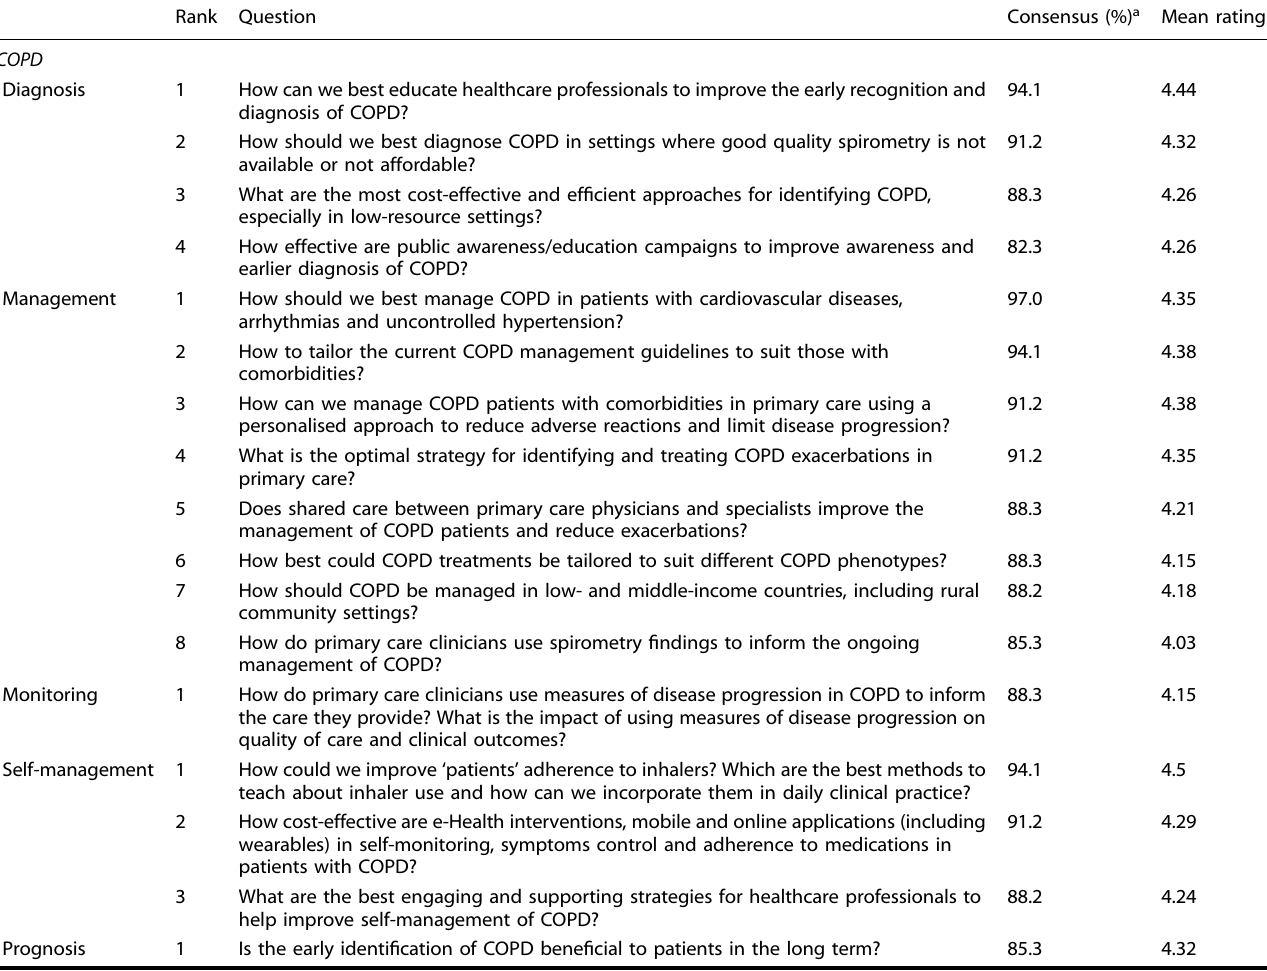
Table 4. Consensus on the research priorities in